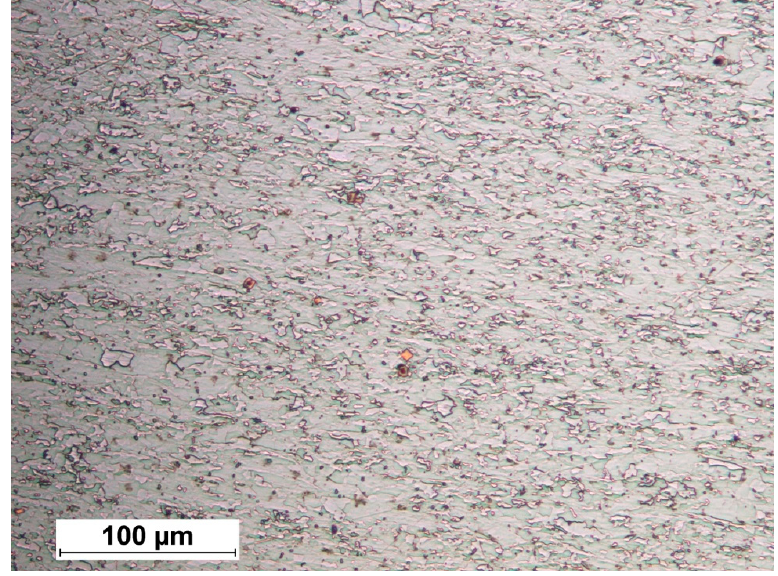
Figure 1. Structure of bainitic–ferritic steel S700MC with visible effects of plastic deformation.